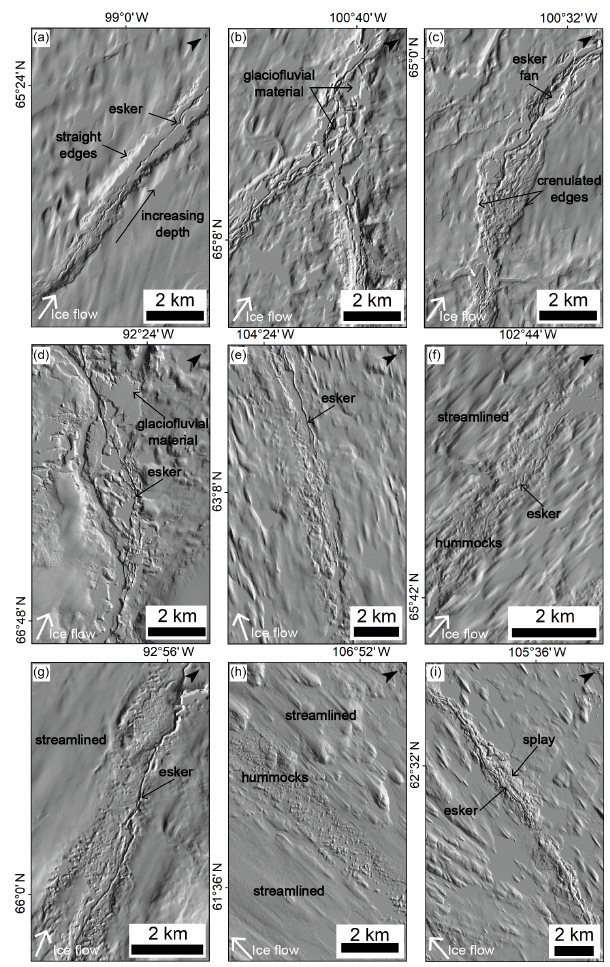
Figure 2. Varying geomorphic expressions of subglacial meltwa- ter flow: (a) increasing depth hummock corridor transitioning into a tunnel valley; (b–d) hummock corridors with negative relief con- taining eskers, esker fans and glaciofluvial deposits. Corridor edges vary in straightness; (e–h) hummock corridors with more subdued relief, largely detectable by the elongated tracts of hummocks which stand out from the surrounding streamlined terrain and often sur- round an esker; (i) an esker surrounded by lateral fans, i.e. esker